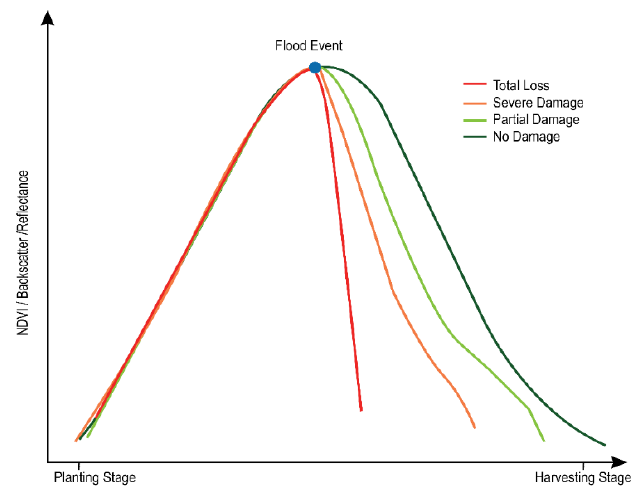
Figure 4. Conceptual diagram for flood crop loss assessment using crop condition profile adapted from Pantaleoni et al. [86], Ahmed et al. [15], Chowdhury and Hasan [102], and Shrestha et al. [16].